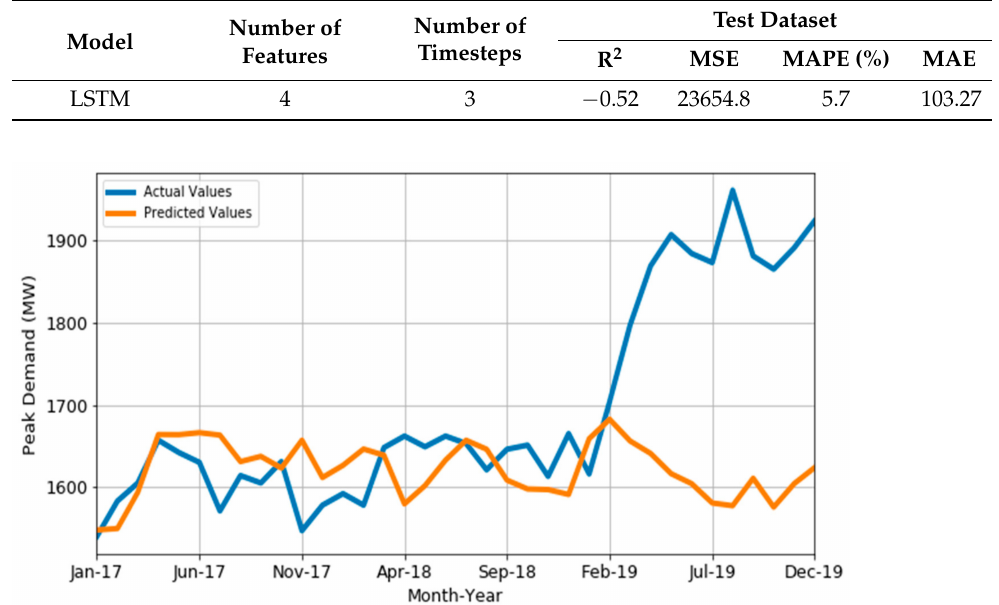
Figure 15. Performance of the LSTM model on the test